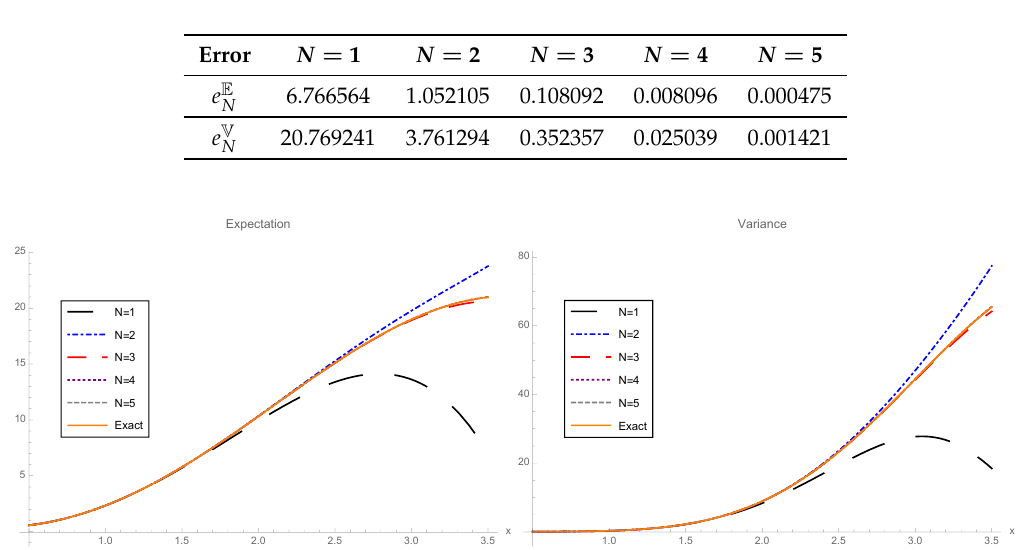
Table 4. Values of errors for the approximations of mean, e E N ∈ { 1,2,3,4,5 } . Example 2.